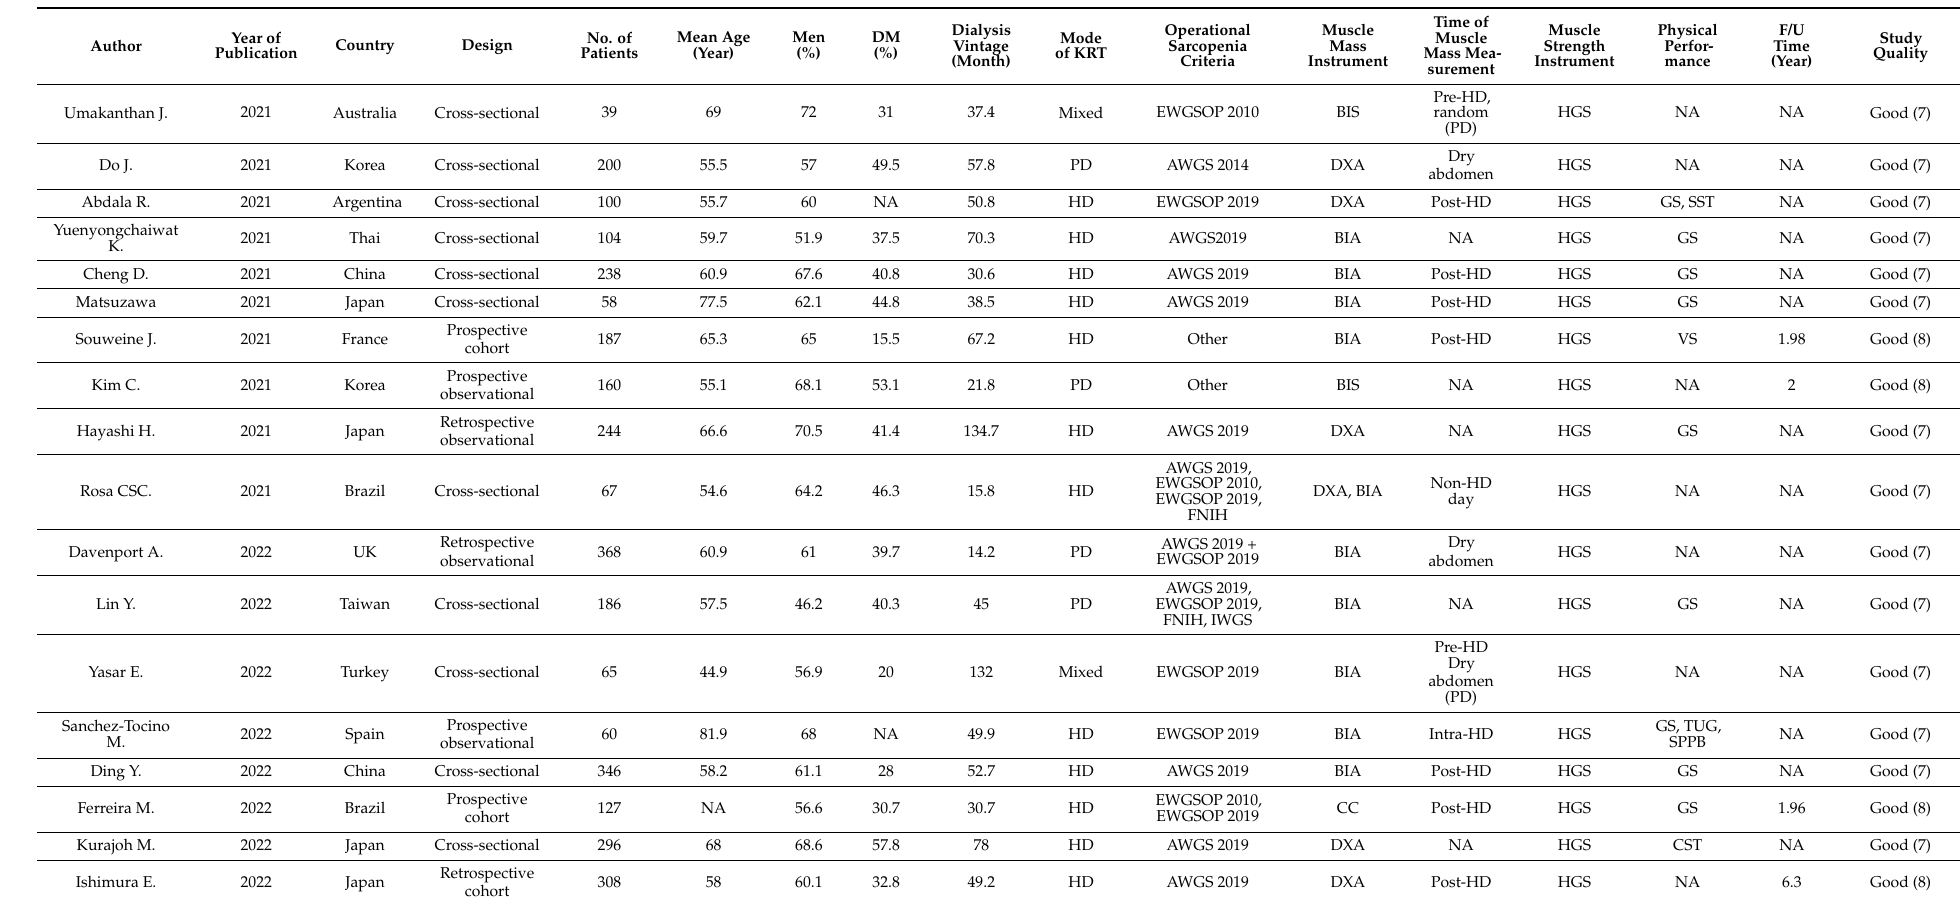
Abbreviations: AWGS, Asian Working Group for Sarcopenia; BIA, bioimpedance analysis; BIS, bioimpedance spectroscopy; CC, calf circumference; CST, Chair Stand Test; DM, diabetes mellitus; DXA, Dual-Energy X-ray Absorptiometry; EWGSOP, European Working Group on Sarcopenia in Older People; FNIH, Foundation for the National Institutes of Health; F/U, follow up; GS, gait speed; HD, hemodialysis; HGS, handgrip strength; IWGS, International Working Group on Sarcopenia; KEMS, knee extensor muscle strength; KRT, kidney replacement therapy; Mixed, peritoneal dialysis and hemodialysis; NA, not available; OLST, One-Leg Standing Test; PD, peritoneal dialysis; SPPB, Short Physical Performance Battery; SST, Sit Stand Test; TUG, Timed Up and Go; UK, United Kingdom; US, United States; VS, Voorrips